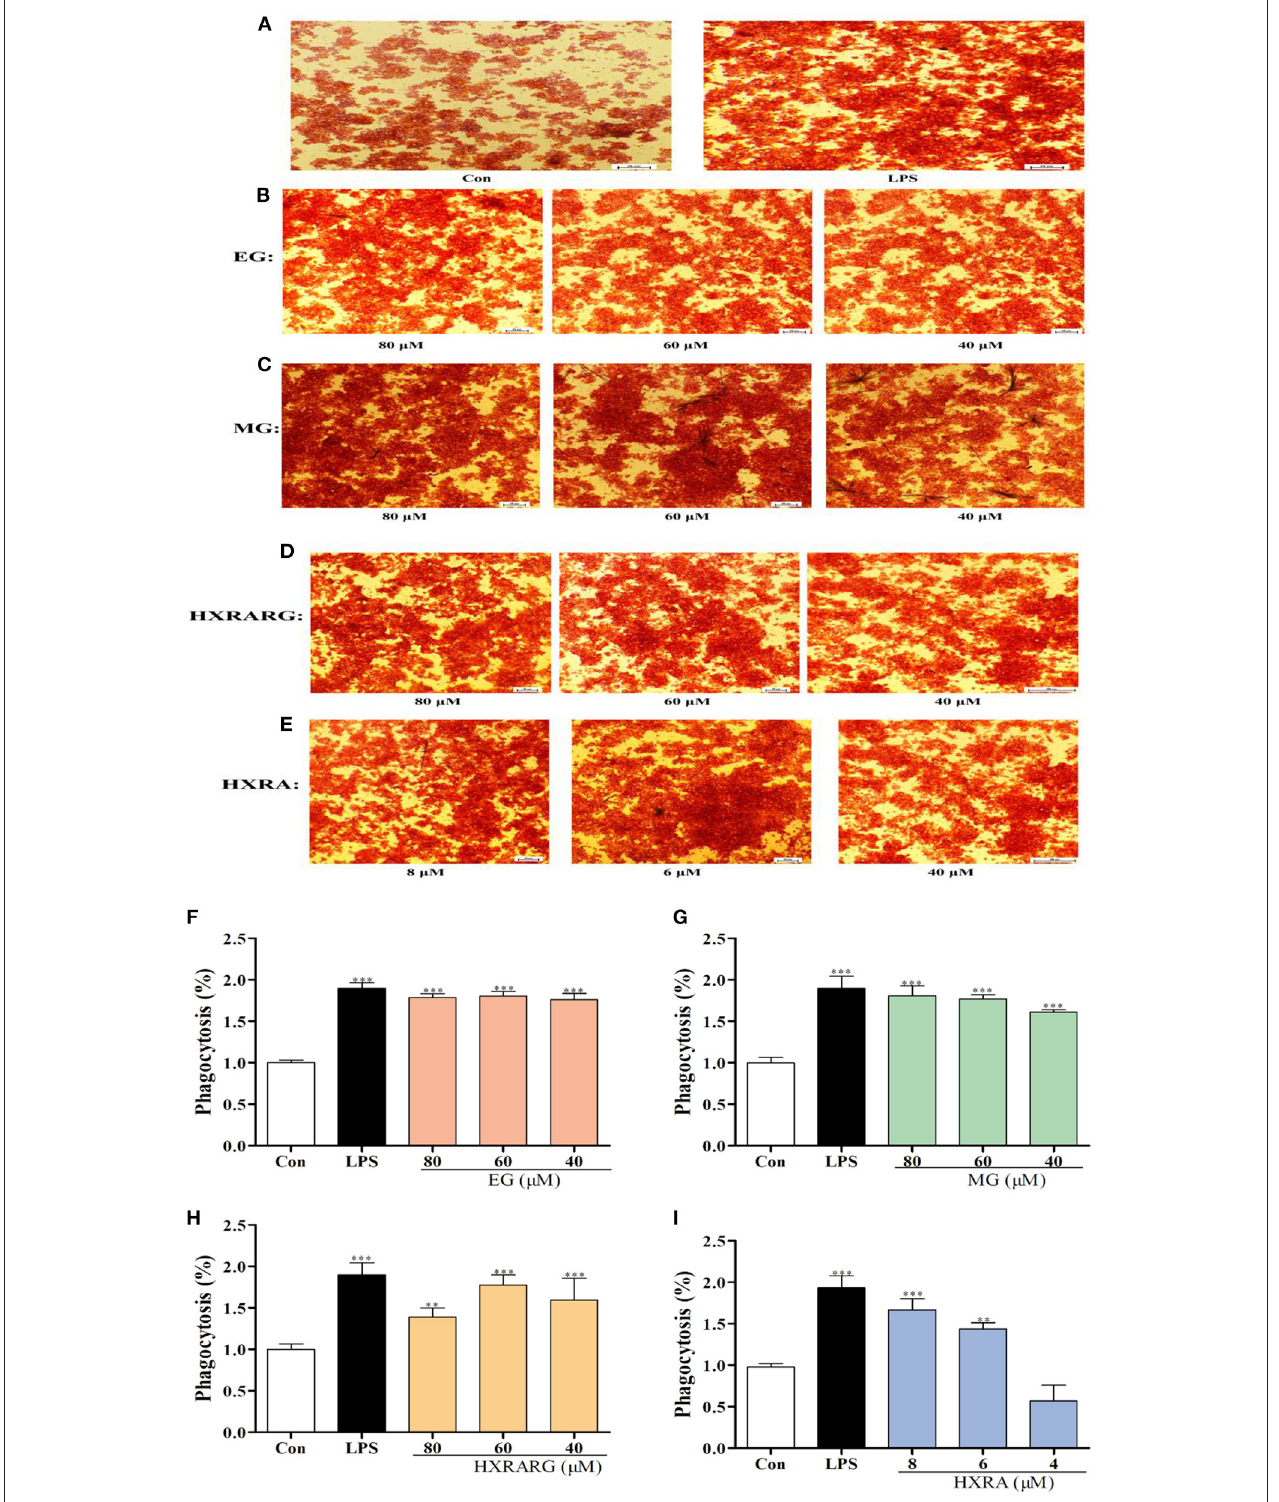
FIGURE 3 | Effects of EG, MG, HXRARG, and HXRA on phagocytosis of neutral red in RAW264.7 cells. (A–E) microscope picture, (F–I) quantitative analysis picture. Data are expressed as the means ± SD. Compared with the control, ** P < 0.01, *** P < 0.001.